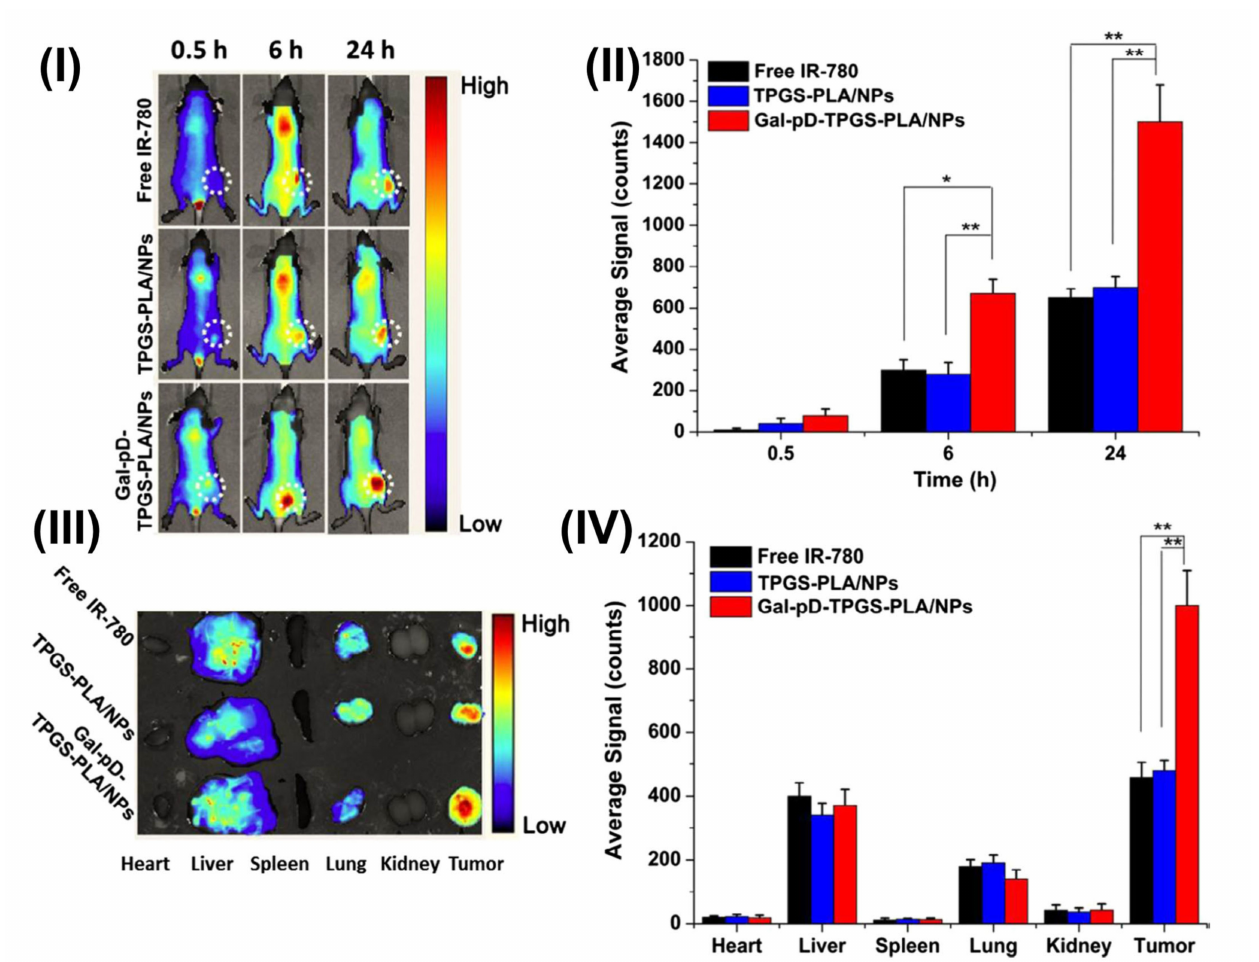
Figure 10. Studies of biodistribution and in vivo imaging were performed on nude mice; ( I ) NIR fluorescence time-lapse pictures of naked mice; ( II ) Tumor NIR fluorescence intensity was measured at the specified time points; ( III ) Major organs and malignancies in NIR fluorescence pictures after injection; ( IV ) Semiquantitative 24 h biodistribution in nude mice. (* Indicate p < 0.05 and ** indicate p < 0.001) Reproduced with the permission from Ref. [117], Figure 7 (Elsevier ©